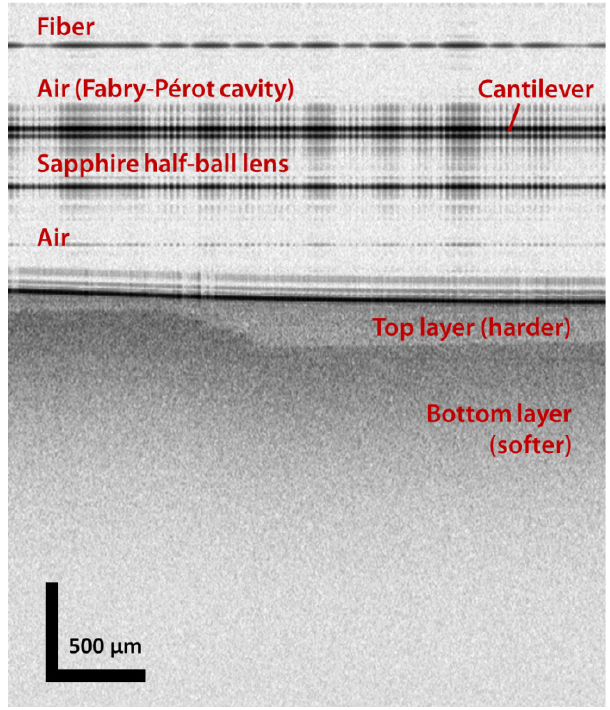
Fig. 4. B -scan acquired with the sensor hovering on top of the sample. The total horizontal length is 3 mm, the vertical length is a 5 mm optical-path-di®erence, and it has been rescaled to represent the true (physical) size of the PDMS sample. The material of each layer has been labeled, the horizontal lines in the upper part are the backre°ections happening at the inter- faces of the components of the sensor.